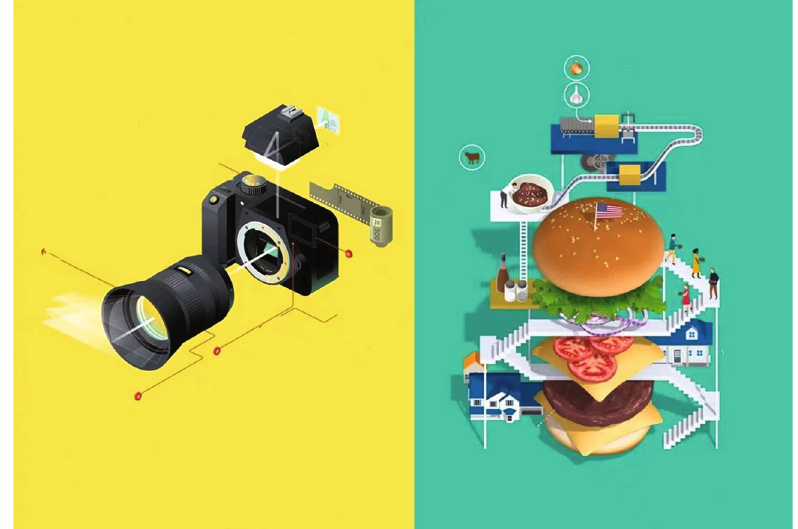
Figure 10: Data visualization